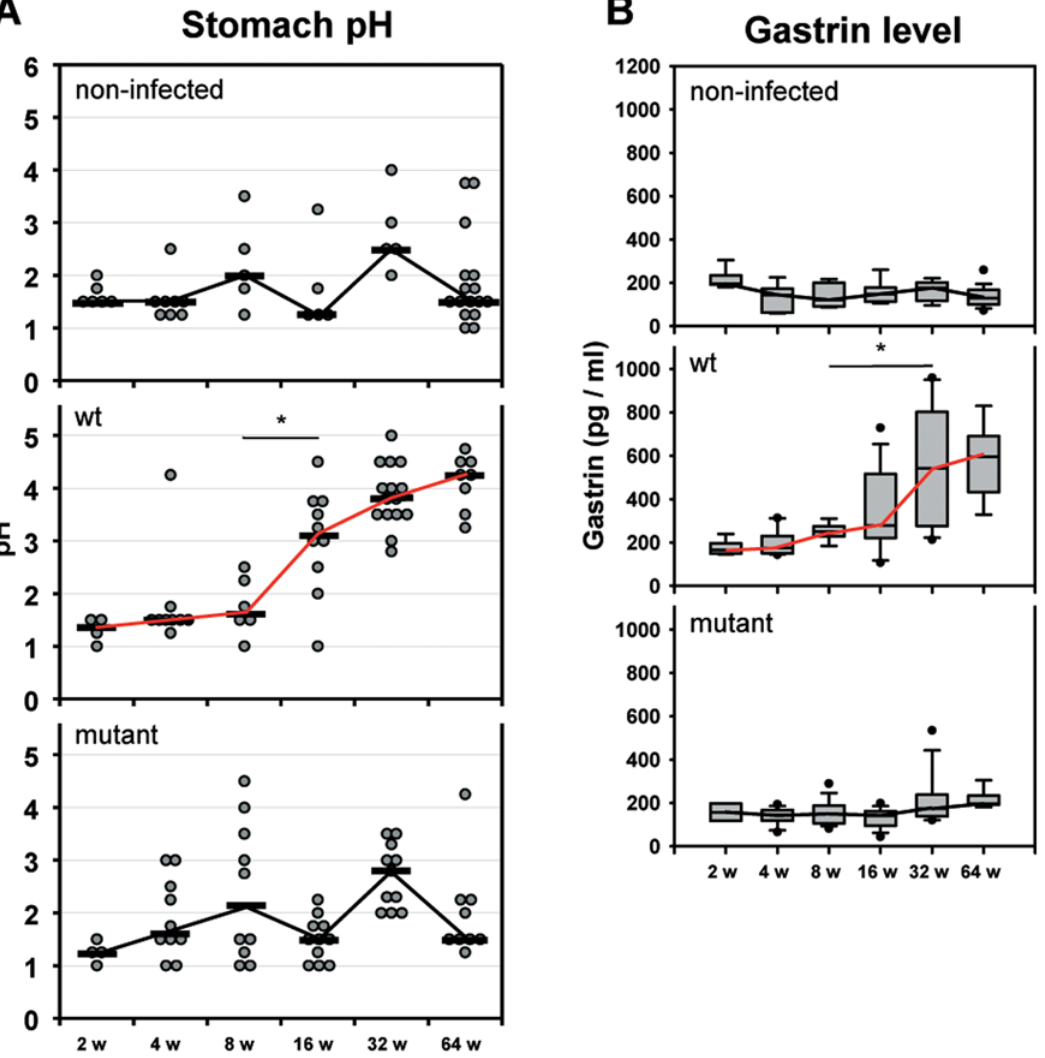
Figure 6. Early inflammatory events cause later physiological changes in H.pylori B128 WT-infected gerbils. The (A) pH and the (B) plasma gastrin level (detection limit , 1 pmol/L) were determined of gerbils orally challenged with H. pylori B128 WT (middle panels) and B128 D cag Y (bottom panels) isogenic mutant strain for 2, 4, 8, 16, 32, and 64 weeks compared with age-matched non-infected controls (upper panels). (*p , 0.05).